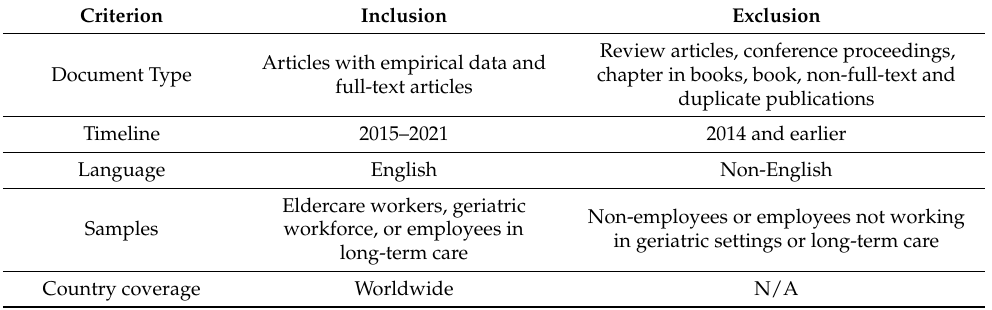
Table 2. Inclusion and exclusion